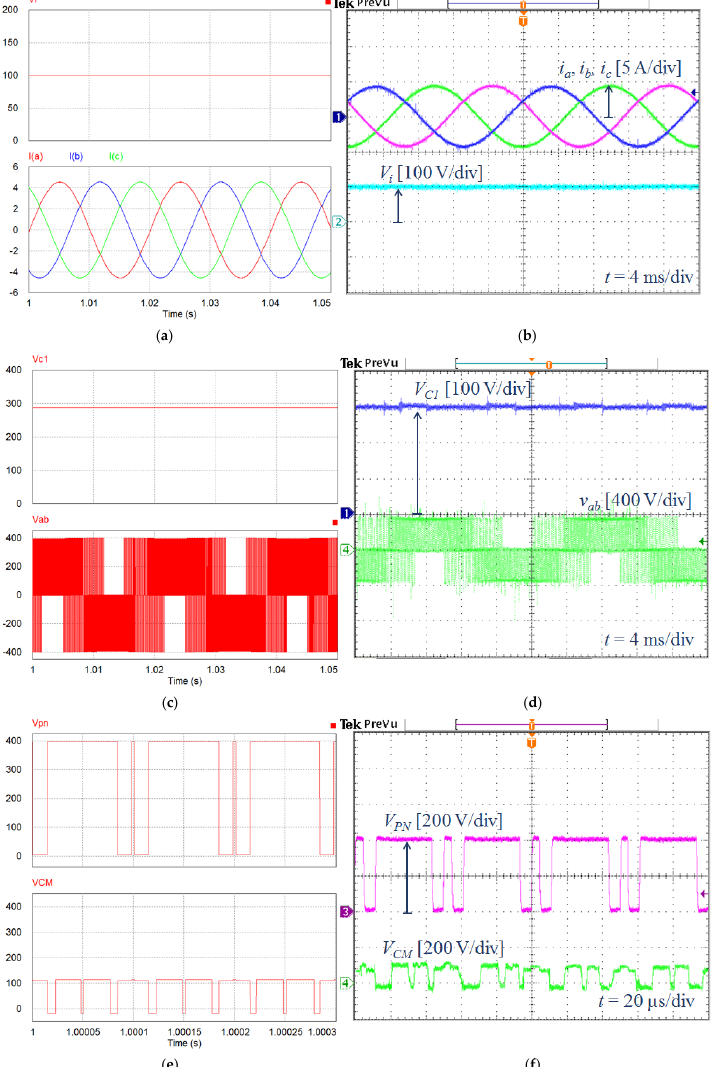
Figure 12. MAqZSI under the proposed CMV-SVM reduction method when V i = 100 V, D = 0.28. ( a , c , e ) Simulation results and ( b , d , f ) Experimental results. From top to bottom: input voltage, output currents, capacitor C 1 voltage, v ab voltage, DC- link voltage, and CMV.